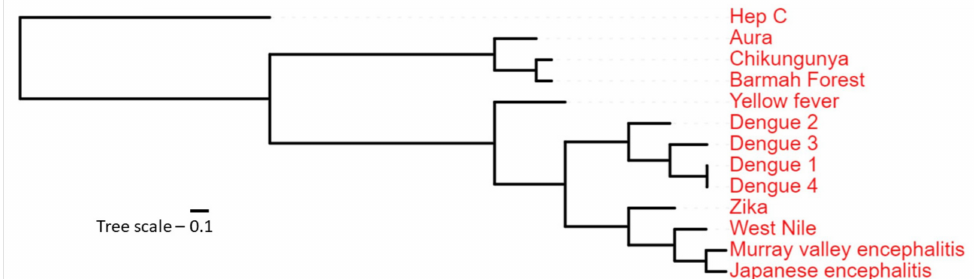
Figure A2. Phylogenetic Tree for Flavivirus Family. Most of the Flavivirus family viruses show a close relation, with hepatitis C diverging from the rest. The non- Flavivirus family viruses cluster separately.